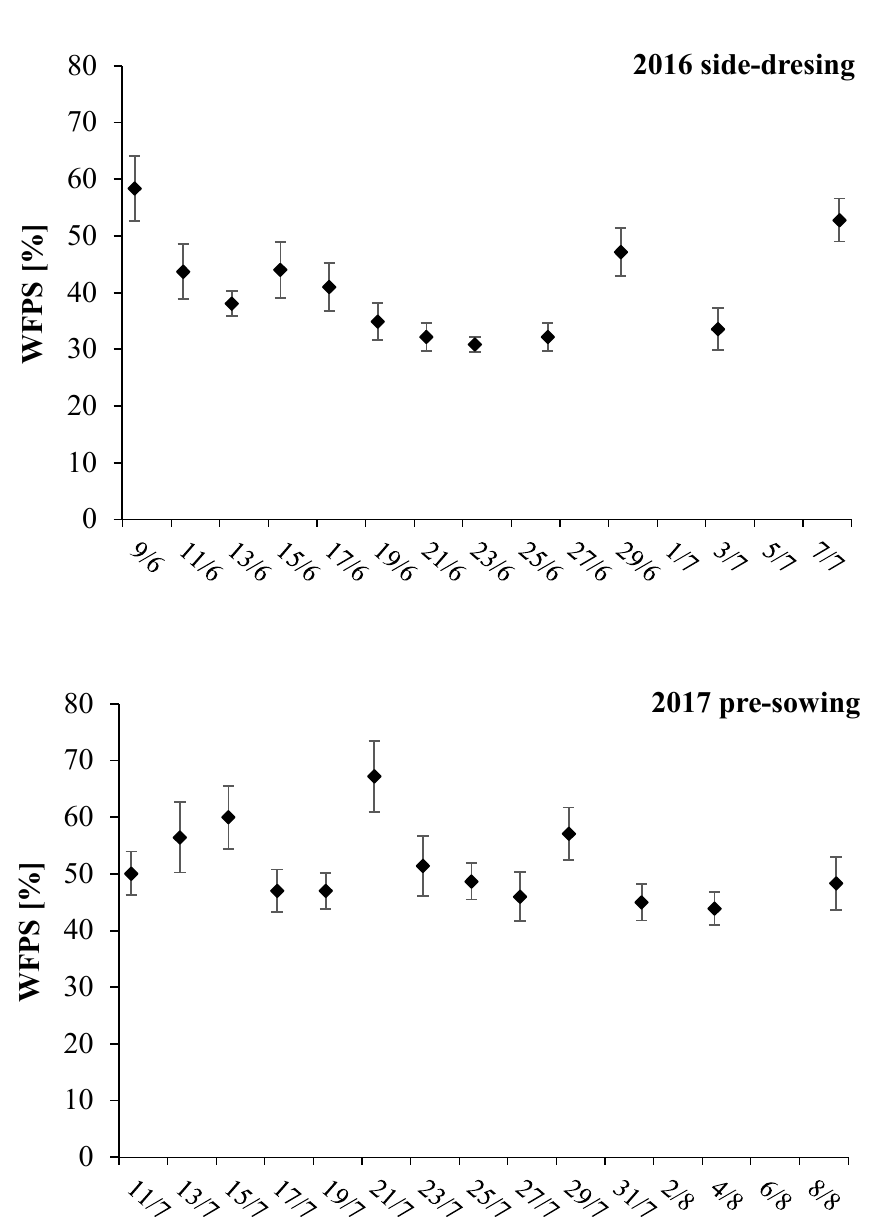
Figure 5. Daily water-filled pore spaces (WFPS, %) calculated as function of the gravimetric soil water content (m 3 m − 3 ), which was measured at 0.3 m soil depth, and the bulk density (mean of the five soil layers). The displayed data were calculated as mean across the three treatments. Error bars represent mean standard error, ±.